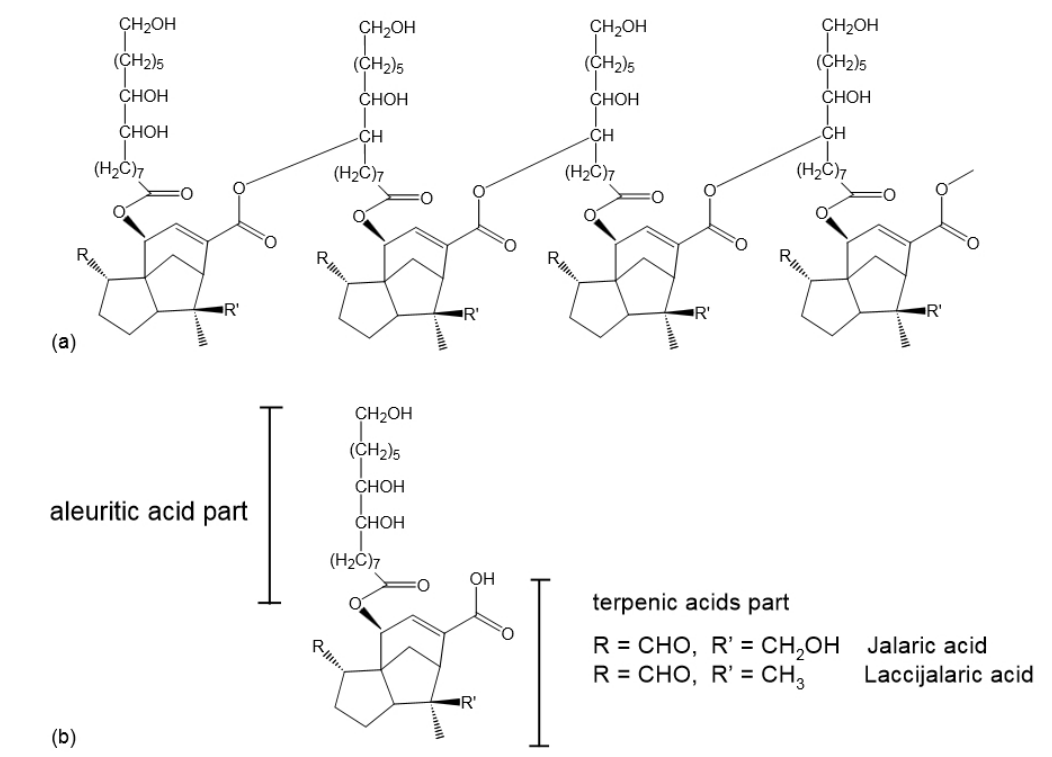
Figure 11. Chemical structure of shellac. Polyesters ( a ), single esters ( b )